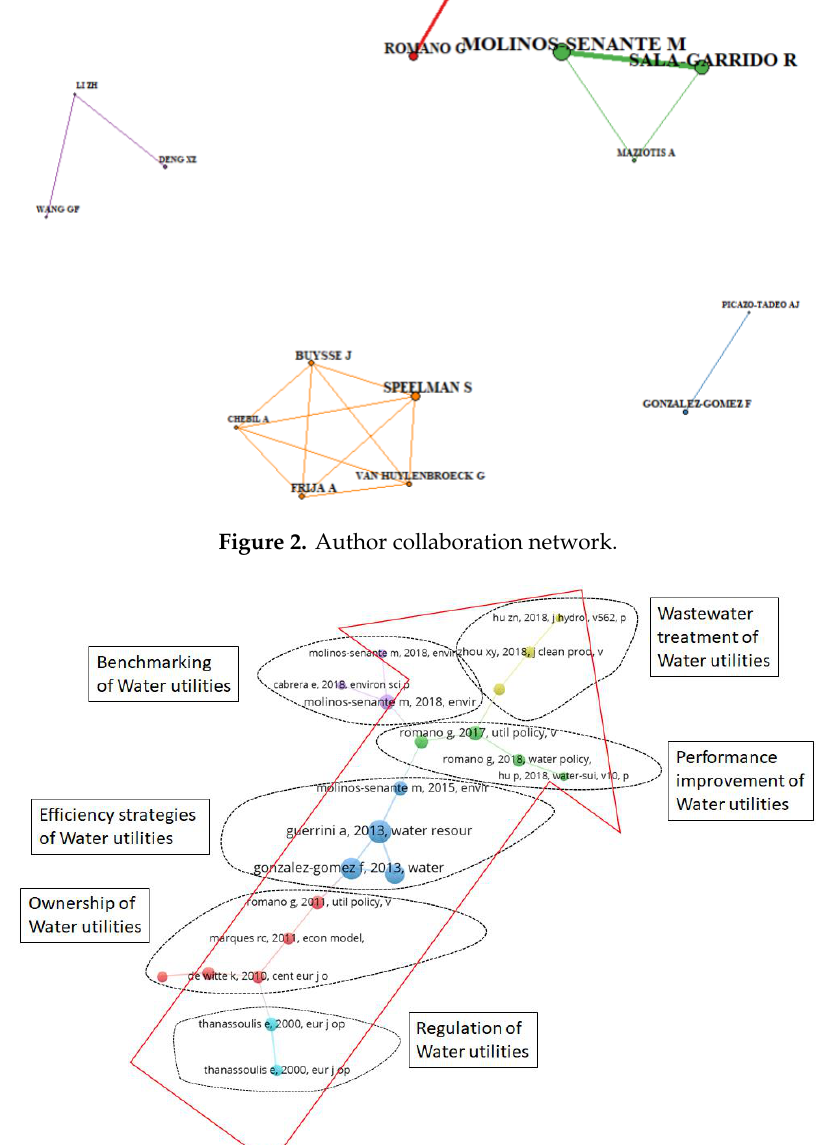
Figure 2. Author collaboration network.